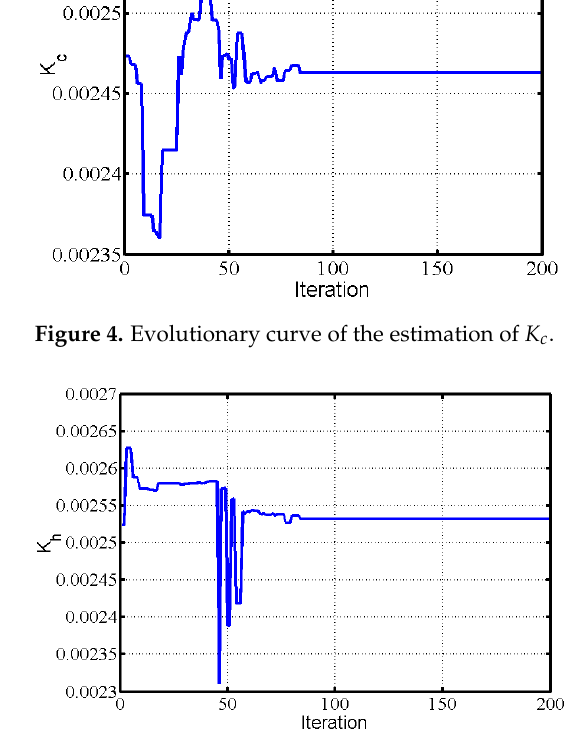
Figure 5. Evolutionary curve of the estimation of K h .